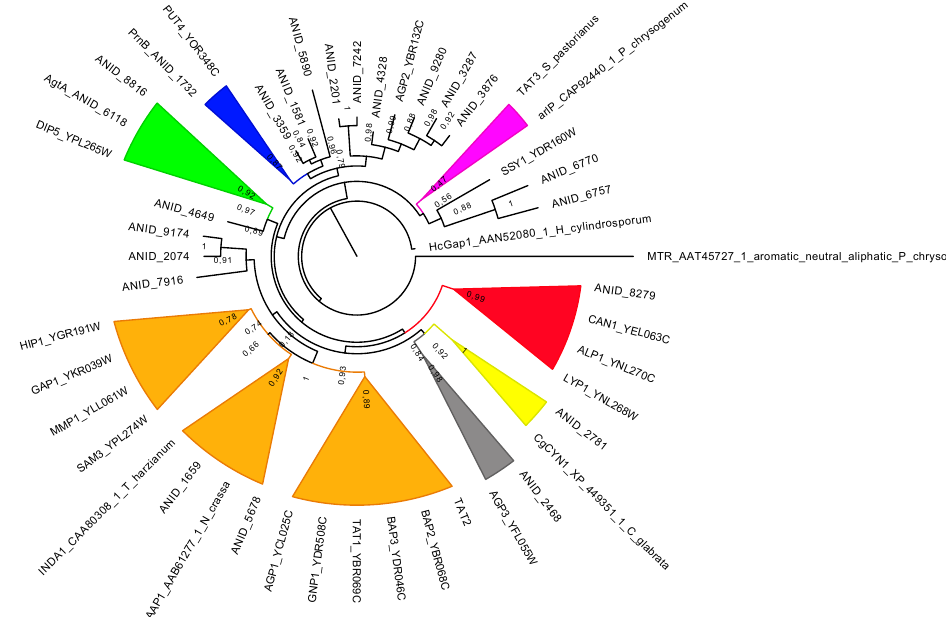
Figure 2. A phylogenetic tree of YATs. All YATs from A. nidulans and S. cerevisiae are included, together with other functionally characterized fungal transporters. The S. cerevisiae proteins TAT1, TAT2, TAT3, GAP1, HIP1, GNP1, AGP1, AGP2, AGP3, BAP2, BAP3, SAM3, MMP1, LYP1, ALP1, CAN1, DIP5, PUT4 and SSY1 were obtained from the Saccharomyces Genome Database (http://www.yeastgenome.org). The sequences of the YATs of A. nidulans were collected and manually corrected for errors occurring by predictions of exon splicing [18]. The previously detected pseudogenes [18], ANID_4604, ANID_8556, ANID_8659 and ANID_5024, are excluded from the tree. Other proteins included are two characterized broad specificity amino acid permeases from Neurospora crassa (NAAP1) [47] and Trichoderma harzianum (INDA1) [48], one Aromatic and aliphatic amino acid transporter from Penicillium crysogenum (MTR, ArlP) [49,50], a general amino acid permease from Hebeloma cylindrosporum (HcGap1) [51] and a cystine-specific transporter from Candida glabrata (CgCyn1) [52]. Alignment was performed with MAFFT G-INS-I with default parameters [53], alignment curation with BMGE with default parameters [54]. A maximum likelihood tree was obtained with PhyML (http://www.atgc-montpellier.fr/phyml/) with automatic selection substitution model (LG) [55]. The tree was drawn with FigTree (FigTree v1.4.2. http://tree.bio.ed.ac.uk/software/figtree/). The tree shown is in a simplified cartoon form in which several branches are collapsed into triangles, only when related to a functionally characterized homologue. Color codes. Red: basic amino acid transporters; green: dicarboxylic amino acid transporters; yellow: putative cystine transporters; dark grey: putative branched amino acid transporters; dark purple: aromatic amino acid transporters; Dark blue: proline transporters; orange: transporters related to a functionally diverse group of structurally related S. cerevisiæ transporters. Within this latter group, there is a subclade of characterized general amino acid transporters from different species. A more comprehensive tree comprising the YATs of all available Aspergilli can be found at Additional file 23 of